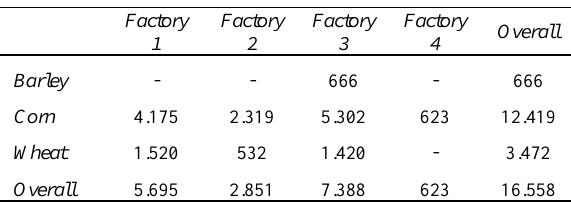
Table 10. Required Storage Space Investments